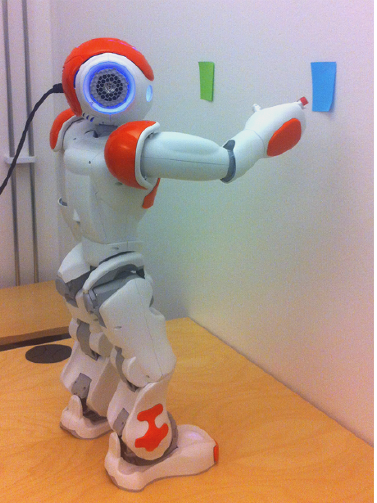
Figure 2. Snapshot of NAO after completing the learning process in the pro- posed